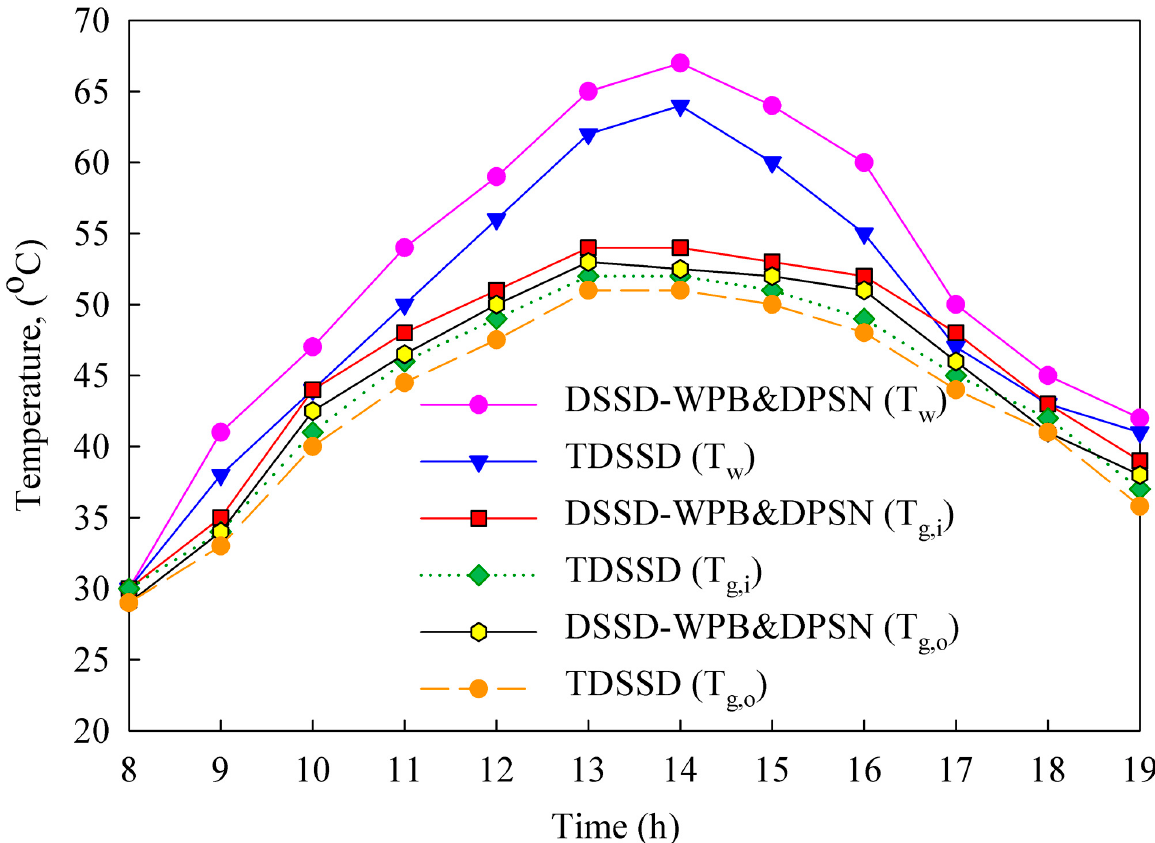
Figure 5. Time dependence: the hourly saltwater (T w ), internal glass coverage (T g,i ), and external glass coverage (T g,o ) temperatures for DSSD-WPB&DPSN and TDSSD.